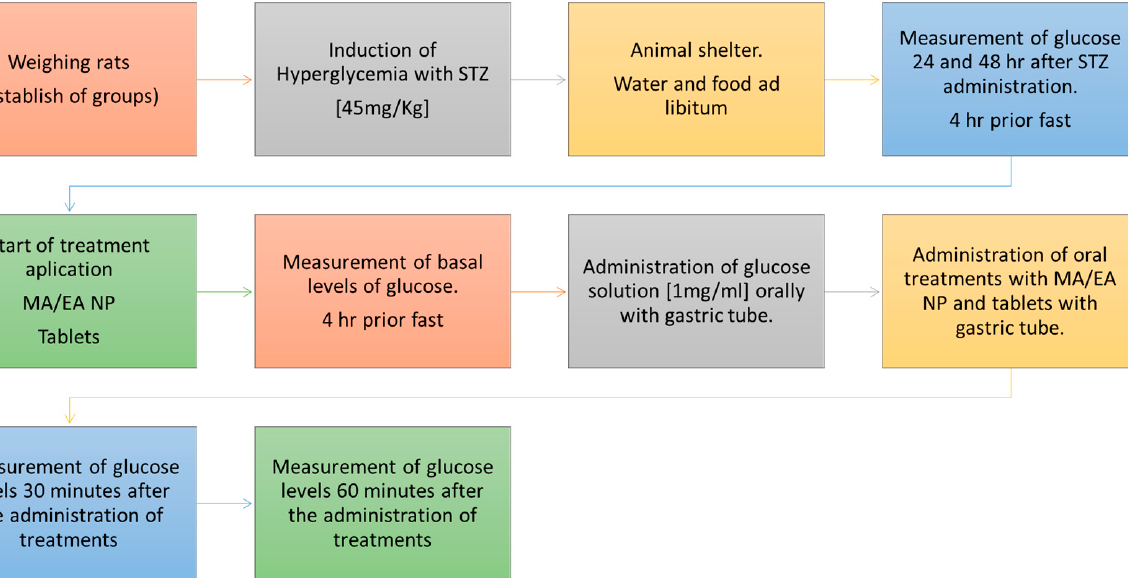
Figure 3. Selection of the dose of STZ to generate hyperglycemia in rats. The blood samples were taken by puncture of the vein located at the base of the tail and the determination of glucose level was carried out with an Accu-chek™ Active digital glucometer using reactive strips. Before sampling, the animals fasted for 4 h and those with glucose levels ≥ 120 mg/dL were considered diabetic. During the experiment, the animals were orally administered with a glucose solution at a concentration of 1 g/mL and immediately afterwad with 1 mL of NP suspension (0.9 mg of glibenclamide) or with the Novag Reglusan™ 5 mg glibenclamide tablet using a gastric tube. The tablet was pulverized and resuspended in Milli-Q water, then loaded into a syringe and administered orally. Two more samples were taken, the first at 30 min and the second at 60 min (Figure 4).